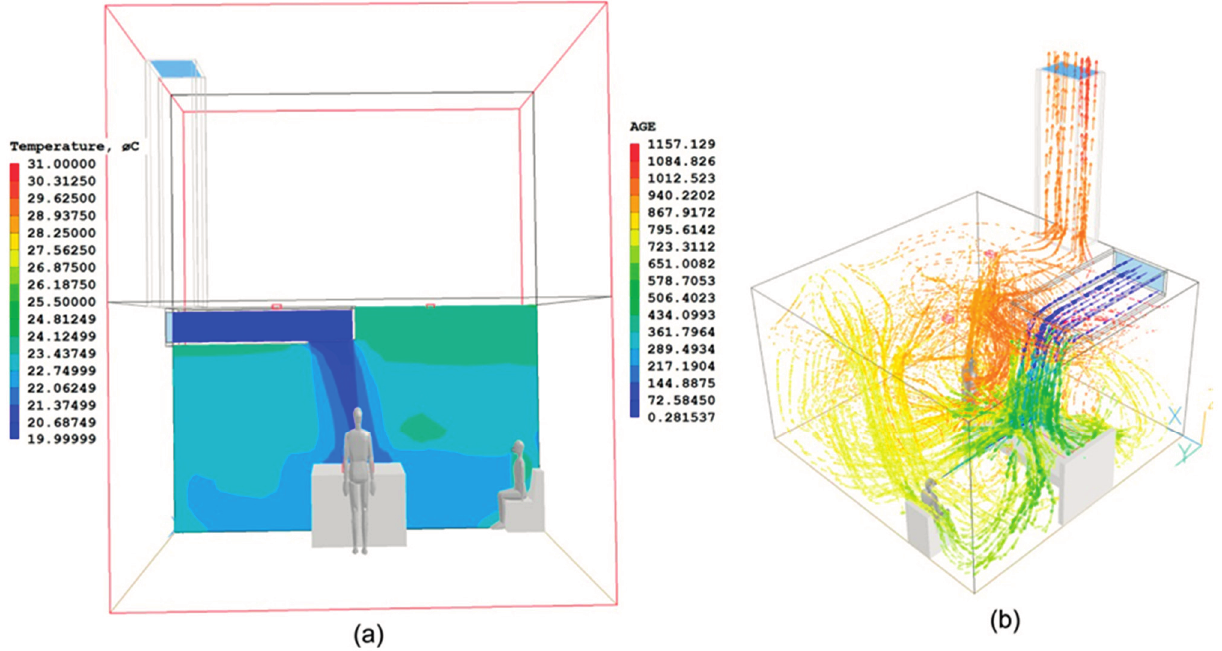
Figure 1. The natural personalised ventilation (NPV) system showing: ( a ) Fresh air delivered over patient’s bed; and ( b ) The overall mixing regime achieved in the ambient space.